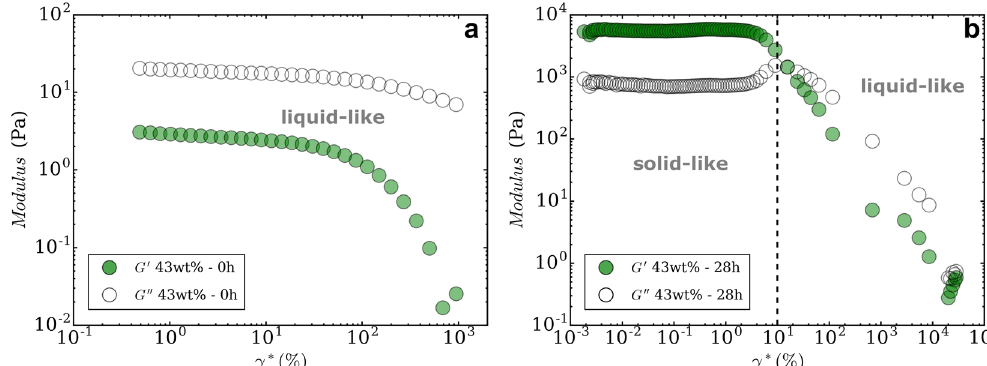
Figure 2. Elastic and viscous modulus vs. strain obtained by amplitude sweep at 1 Hz for 43 wt% boehmite suspension after aging for ( a ) 0 h and ( b ) 28 h. Before gelation, G ′′ values are always higher than G ′ at all strain values, unlike at 28 h where the gel transitions from a solid-like to a liquid-like